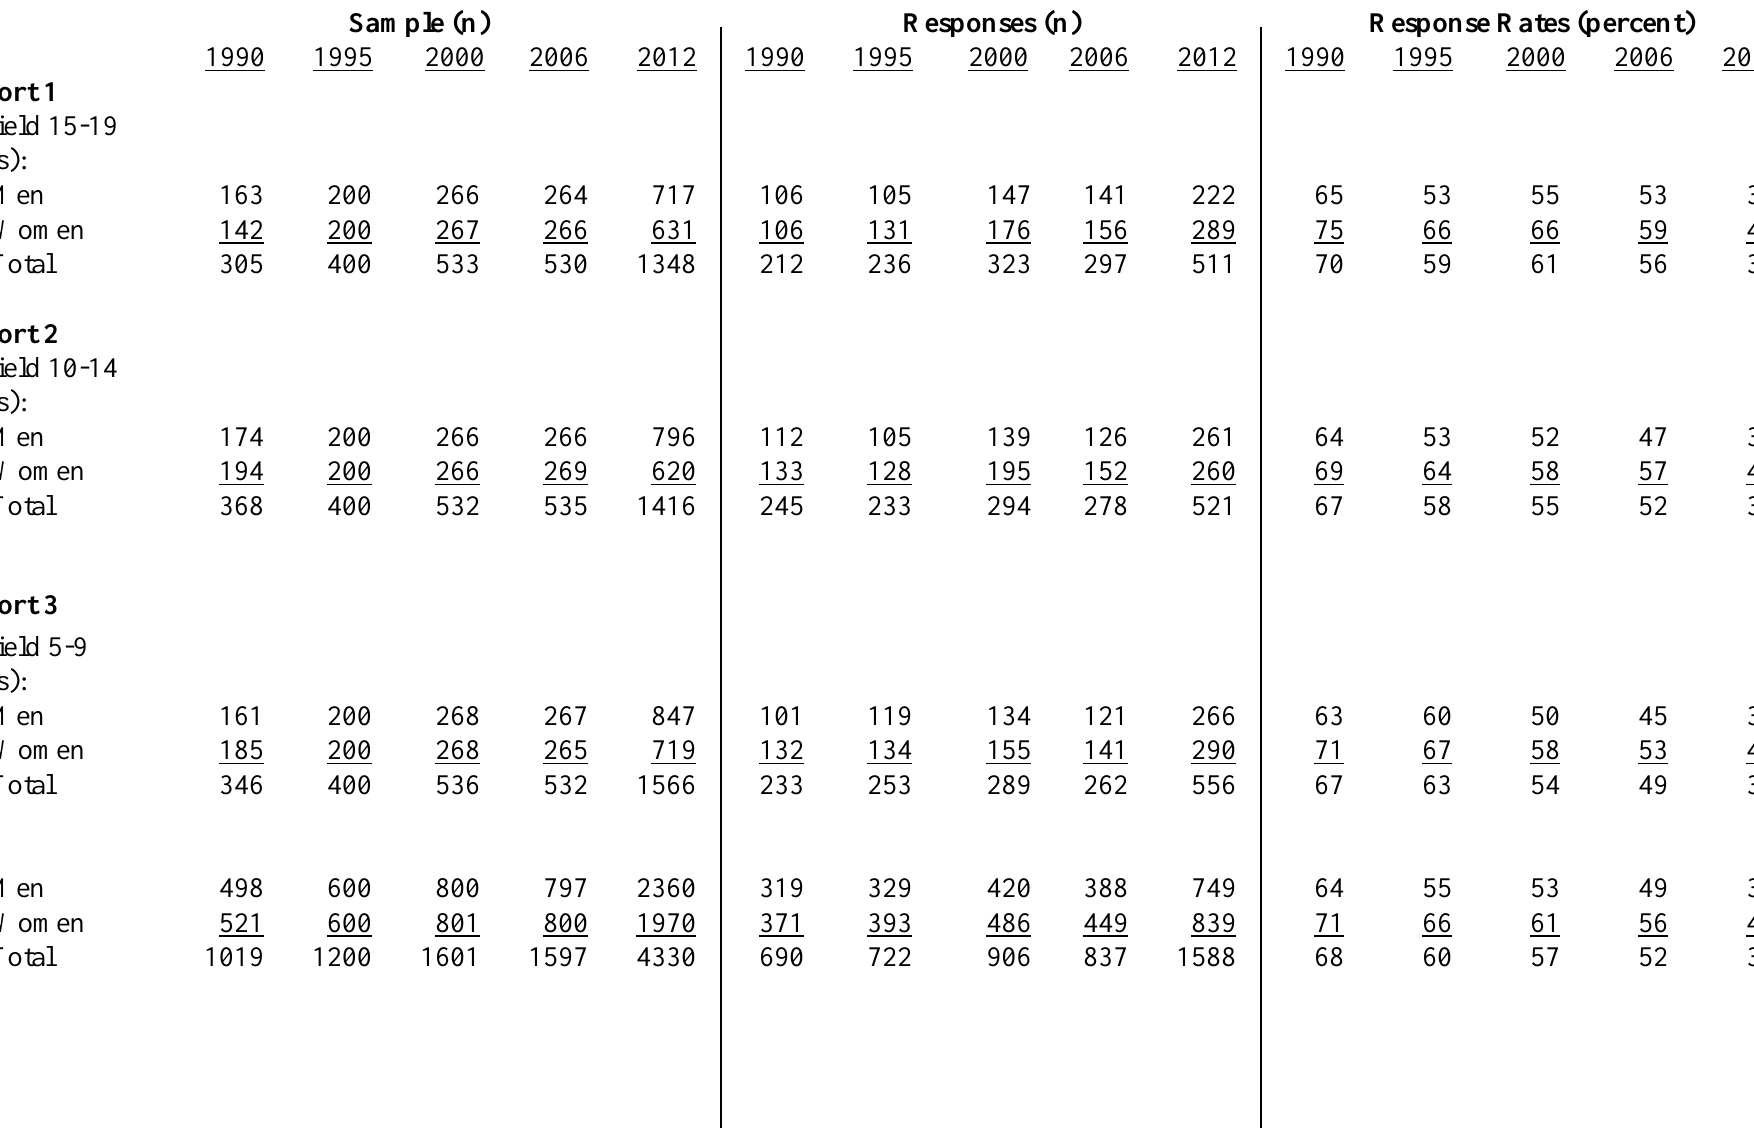
Table 1. Sample and Response